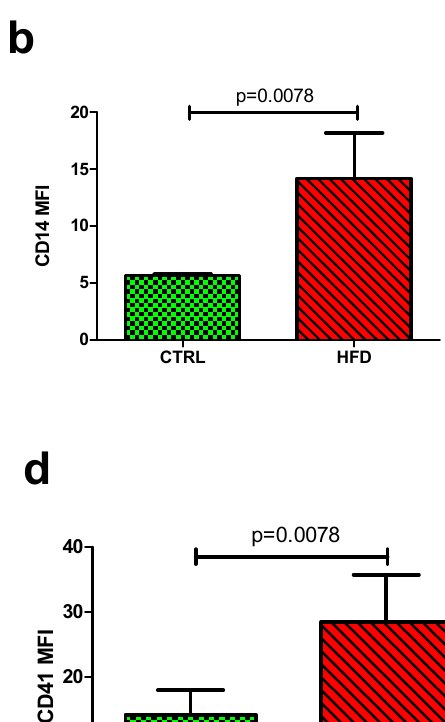
29.96 ± 11.40 and post-ADP stimulation 28.94 ± 10.79, p = 0.4375 (Table